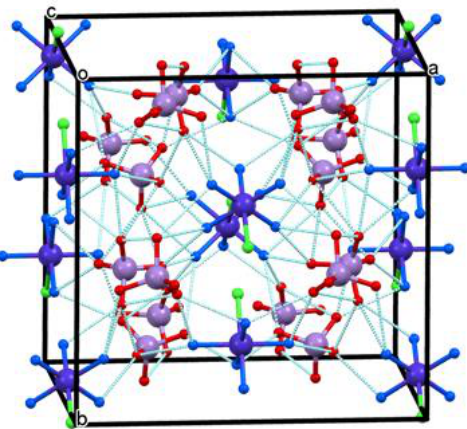
Figure 2. Parallel [Co(NH 3 ) 5 Cl] 2+ (dark violet octahedra) and MnO 4 − (light violet tetrahedra) layers in the bc plane (view in the direction of the c axis).